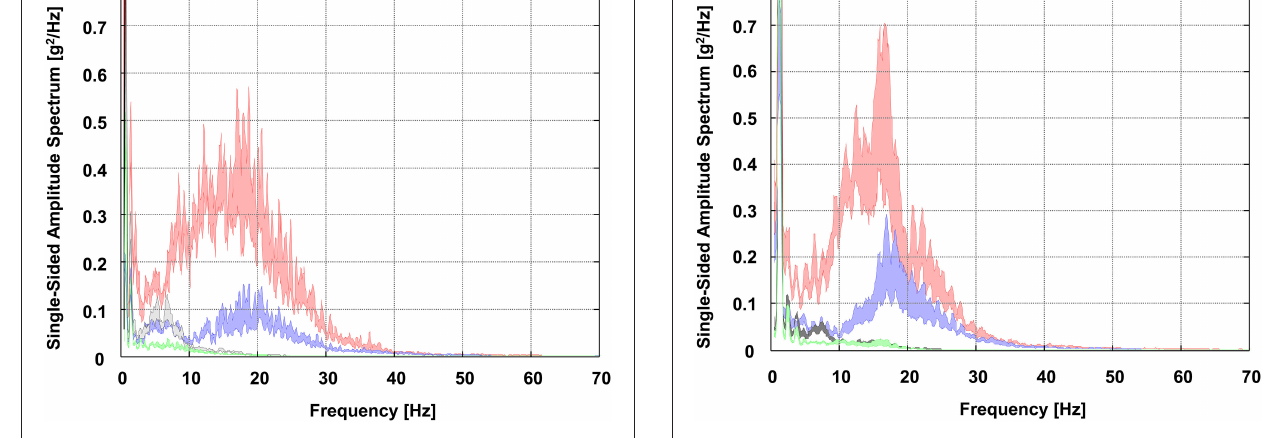
Frontiers in Physiology |